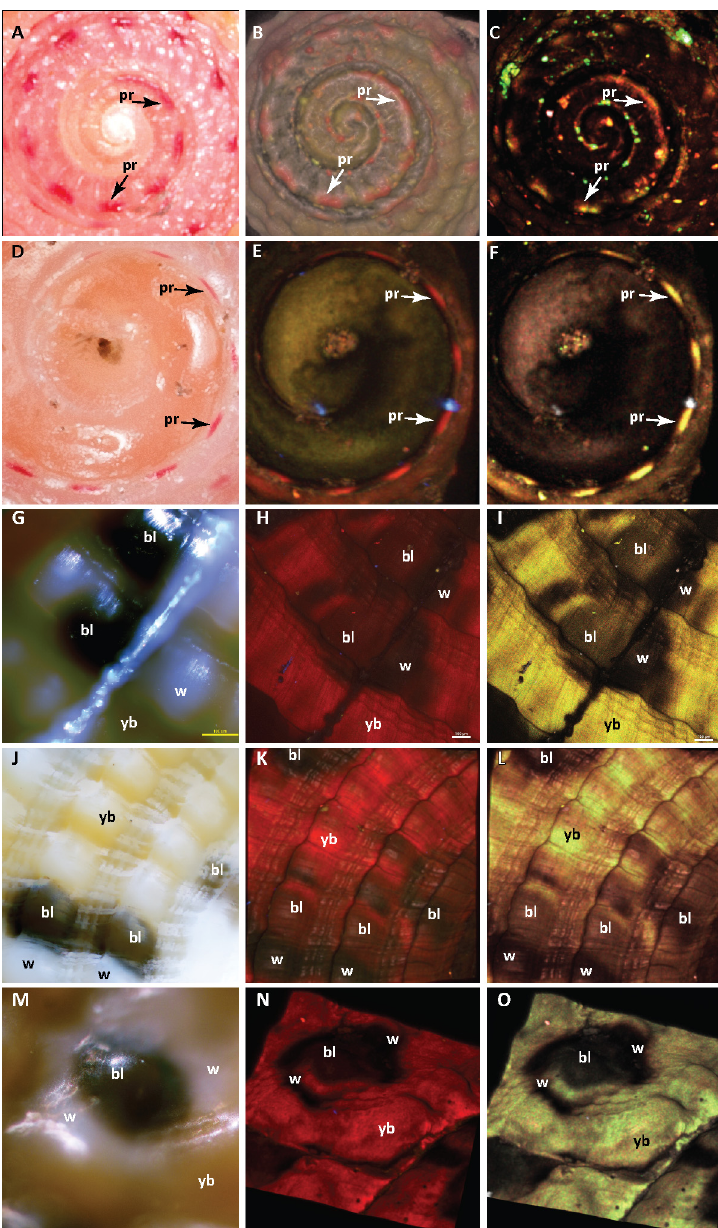
Fig 3. Confocal images showing uroporphyrin distribution in areas of pink-red and yellow-brown pigmentation on Clanculus margaritarius shell. Shell images on each line are of a single shell and are in approximately the same orientation and magnification. (A-C) Top of shell, Clanculus margaritarius A (specimen #2). (A) Visible pink-red pigmentation. (B) Shaded volume 3D projection of a spectrally mixed image of the same shell showing fluorescent red areas congruent with visible pink-red pigment. (C) Maximum intensity projection of a spectrally unmixed image showing distribution of uroporphyrin I and III. (D-F) Clanculus margaritarius B (specimen #10). (D) Visible pink-red pigmentation. (E) Maximum intensity projection of a spectrally mixed image showing fluorescent red areas under UV light congruent with pink-red pigment. (F) Maximum intensity projection of a spectrally unmixed image showing distribution of uroporphyrin I and III. (G-L) Two different areas with yellow-brown, black and white colouration on shell of C . margaritarius A (specimen #2). (M-O) Yellow brown areas on shell of Clanculus margaritarius B (specimen #10). (G, J, M) Visible pigmentation for approximately the same areas as used in analyses. (H, K, N) Maximum intensity projection of spectrally mixed images showing red fluorescent areas under UV light congruent with yellow- brown pigmentation. Panel N is shown in 3D. (I, L, O) Maximum intensity projection of spectrally